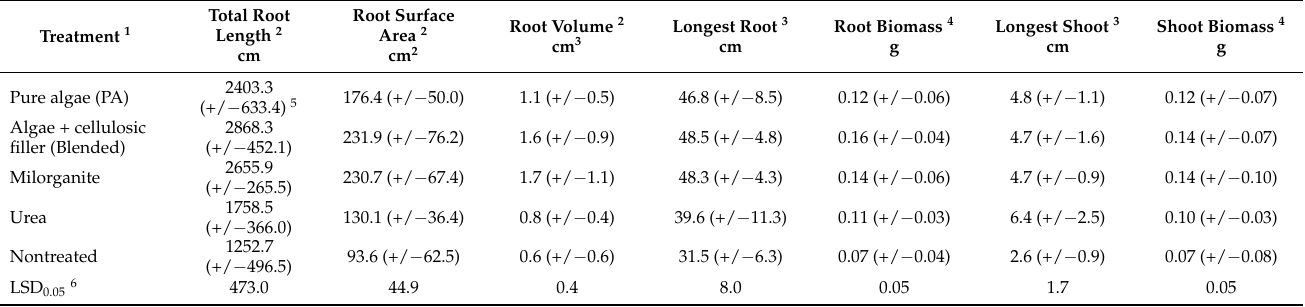
Table 3. Effects of wastewater algae-based fertilizers on Kentucky bluegrass root and shoot parameters growing in a greenhouse in Ames, IA, in 2019–2020 and